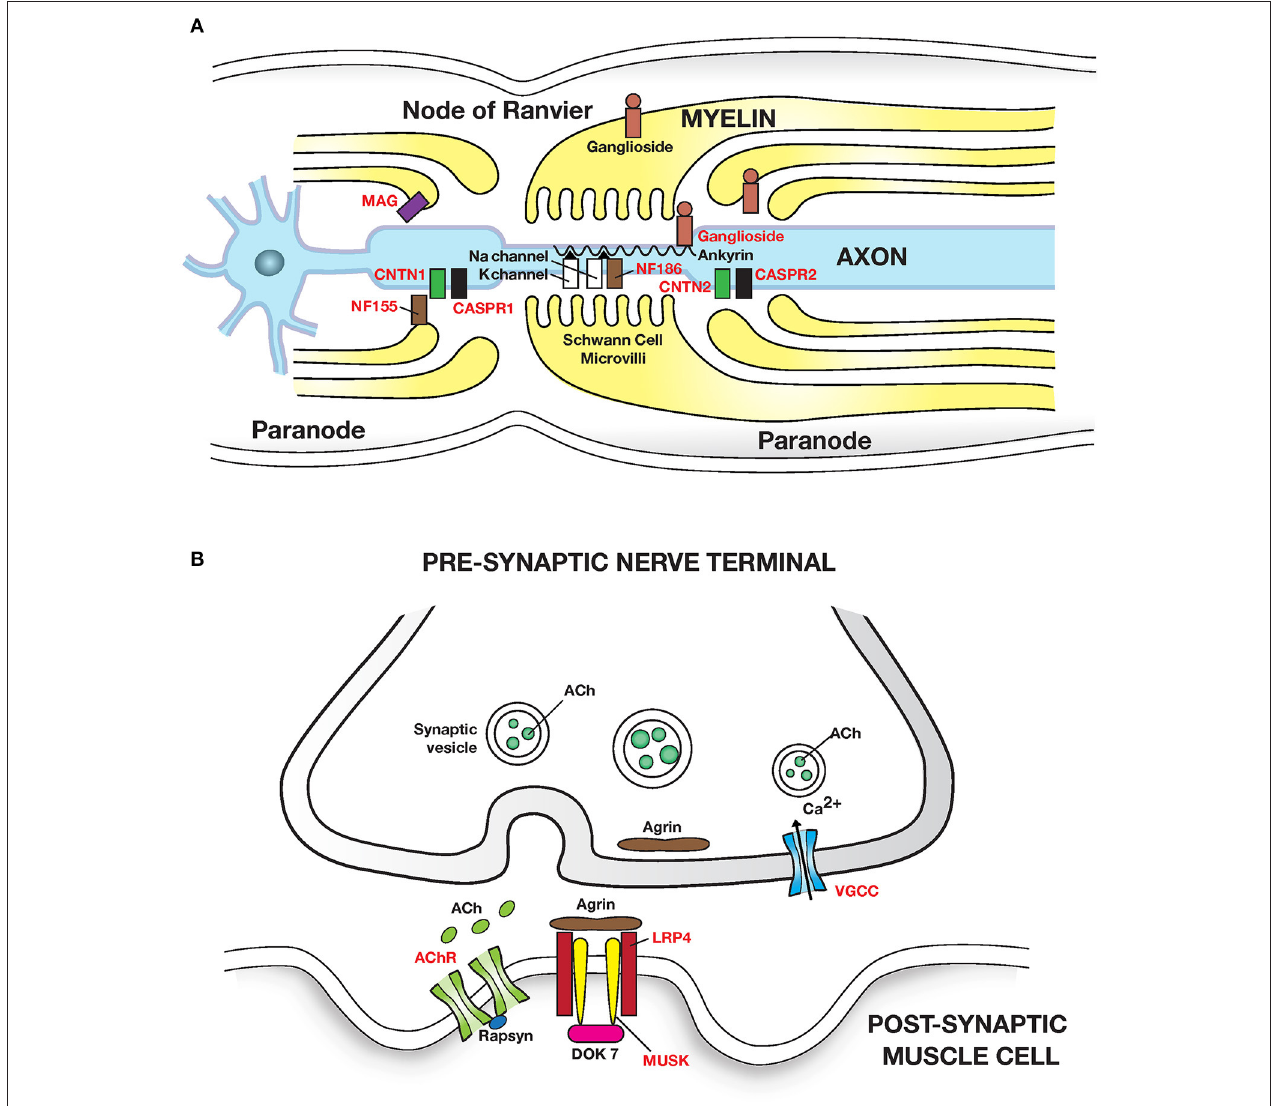
FIGURE 2 | Autoimmune diseases of peripheral nerve and neuromuscular junction: (A) Peripheral nerve: Guillain Barre syndrome and its variants have been linked to autoantibodies to gangliosides (glycosphingolipids) which are abundant in peripheral nerves. Autoantibodies cause segmental demyelination and disruption of Na channel clustering. GM1 and GalNAc-GD1a ganglioside are most abundant in axolemma of motor nerves and nodes of Ranvier and are associated with motor phenotypes. GQ1b is enriched in oculomotor cranial nerves and is linked with Miller Fisher syndrome. Multifocal motor neuropathy (MMN) is linked to anti-GM1 ganglioside antibodies. MGUS neuropathy is linked to autoantibodies to myelin associated glycoprotein (MAG). Chronic inflammatory demyelinating polyneuropathy (CIDP) is linked to autoantibodies (in < 10% patients) to the nodal and paranodal adhesion proteins neurofascin 186 and 155 (NF186, NF155); contactin 1 (CNTN1); contactin associated protein (CASPR1 and 2) which disrupt axon-Schwann cell contacts. Adhesion molecules are attached to the cytoskeleton by proteins such as Ankyrin/Spectrin. (B) Neuromuscular junction: Myasthenia gravis caused by autoantibodies to the (i) post synaptic Acetylcholine receptor (AChR); IgG1 and IgG3 autoantibodies activate the complement cascade leading to structural damage to postsynaptic membrane and loss of AChR. (ii) Muscle skeletal receptor tyrosine protein kinase (MUSK). MUSK autoantibodies (Fab- arm exchanged monovalent IgG4) block agrin (released from motor nerve terminals) induced MUSK—LRP4 (low density lipoprotein receptor related protein 4) interaction, and disrupt clustering of AChR. Dok7, Downstream of tyrosine kinase 7: cytoplasmic protein that activates MUSK in concert with agrin and LRP4. Lambert-Eaton myasthenic syndrome is caused by autoantibodies to presynaptic P/Q type voltage gated calcium channels (VGCC) disrupting Ca 2 + influx; Ca 2 + is essential for release of ACh from presynaptic vesicles. Antigenic targets of autoantibodies are shown in red text in all figures. Autoantibodies associated with inflammatory myopathies are shown in Table 3